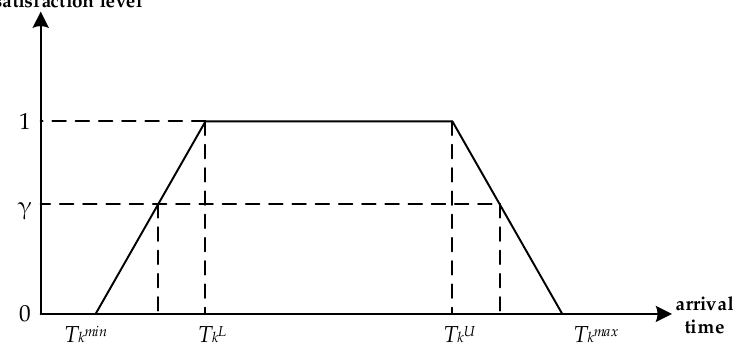
Figure 1. Satisfaction level in the fuzzy soft time window.